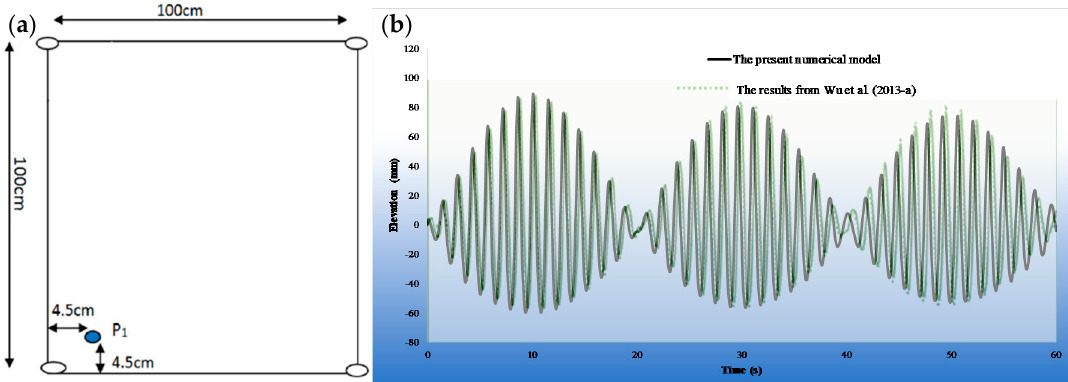
Figure 12. Comparison of numerical model used in the current study with the results from Wu et al. (2013-a) with 250 mm of water and an amplitude of 5 mm, with a rotation orientation of 30° and ω = 0.93 ω res at location P1: ( a ) tank plan; ( b ) comparison of water elevations.